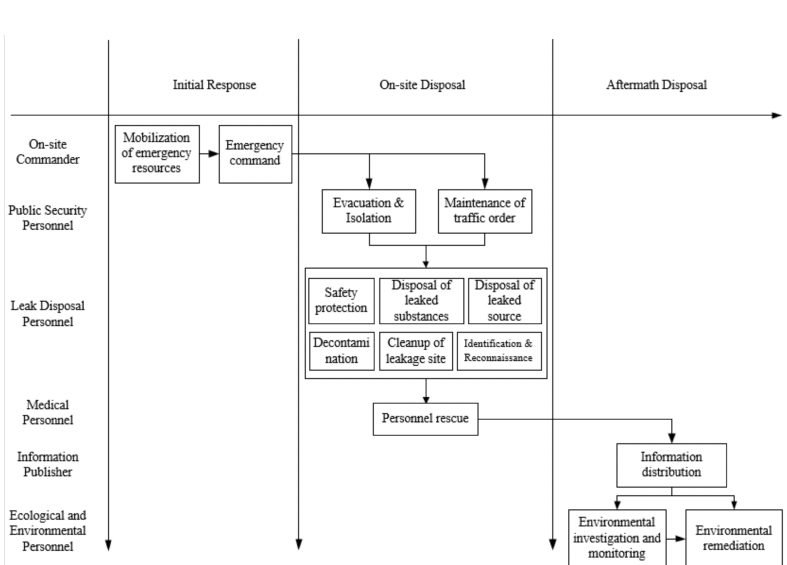
Figure 2. Emergency activities: laws, regulations and